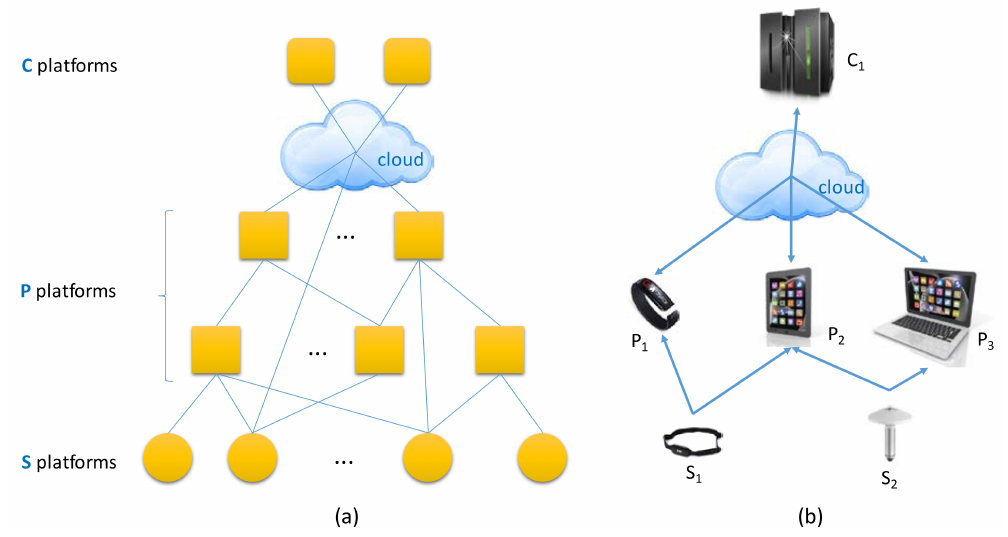
Figure 2. IoT communication network. ( a ) General scheme; ( b ) Example case.